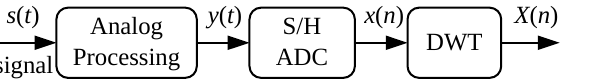
Figure 1. The general structure of the analyzed signal processing